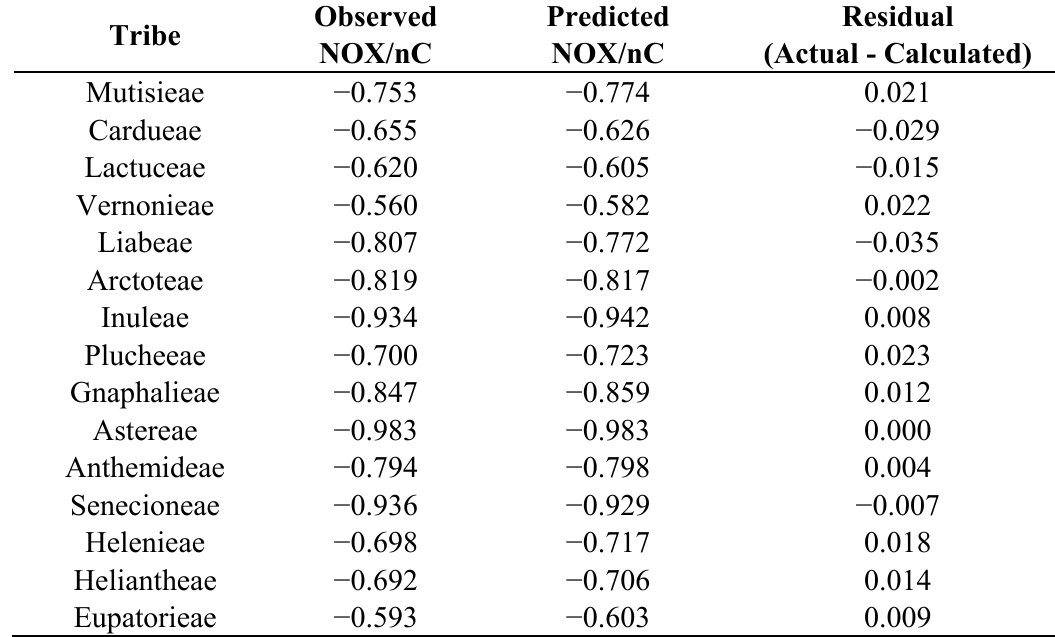
Table 2. Mean values for the observed degree of oxidation (NOX/nC) for 15 tribes of the Asteraceae family and values for the degree of oxidation predicted by equation (1) and the respective